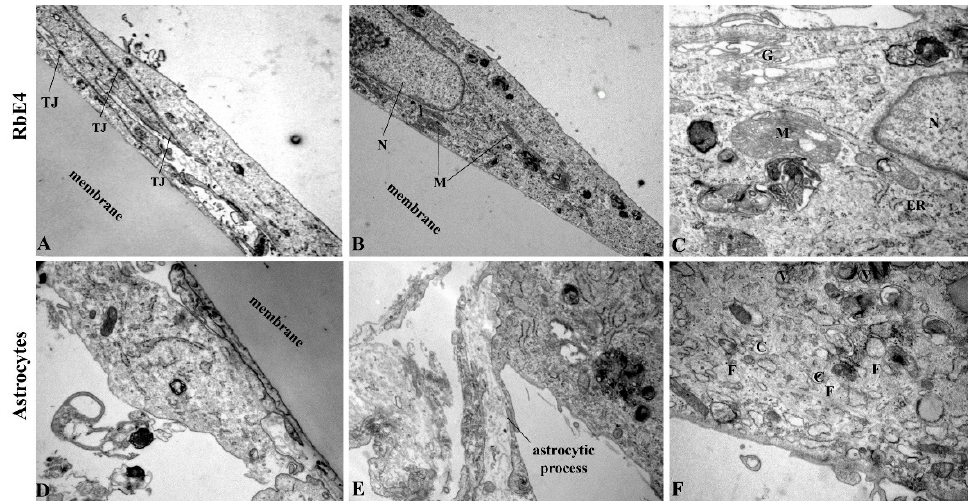
Figure 2. TEM pictures of RbE4 cells and astrocytes grown on cell culture inserts. ( A – C ) Endothelial RbE4 cells show characteristic oval shape with overlapping ends and pronounced tight junctions (TJ). ( D – F ) Astrocytes are bigger than RbE4 cells with less mitochondria (M), but with many caveolae (C), clathrine-coated vesicles (V) and bundled filaments (F). (N—nucleus; G—Golgi apparatus; ER—endoplasmatic reticulum). Magnification (A)—3000X; (B, D)—6000X; (C,E)—10000X; (F)—12000X.